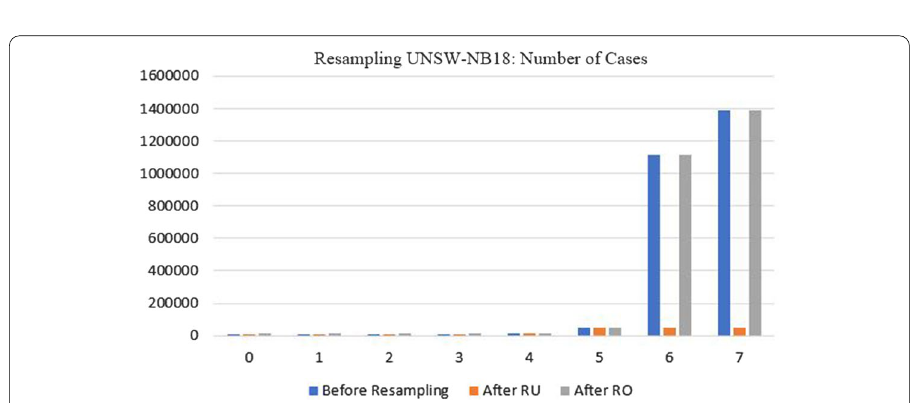
Fig. 10 Resampling of UNSW-NB18